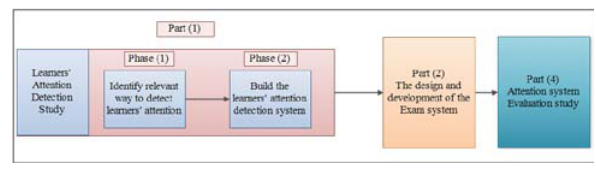
Figure 1 . Research Framework.